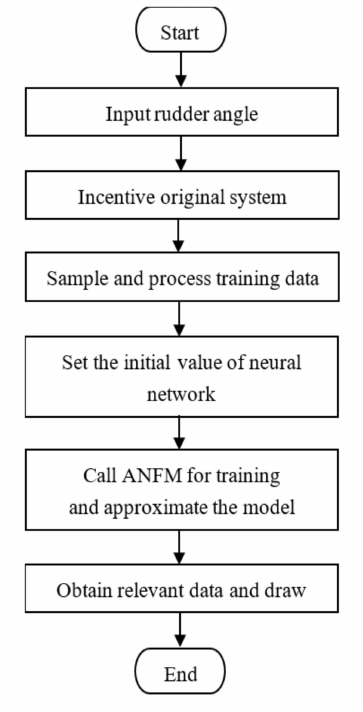
Figure 6. Flow of the approximation